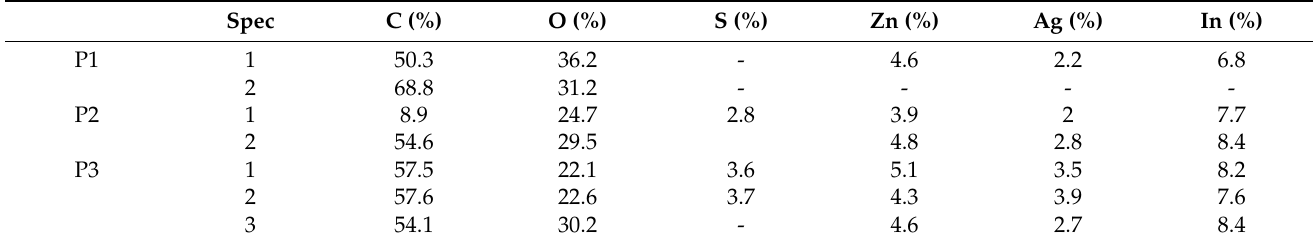
Table 2. EDX analysis at the blue marked spots in Figure 5.